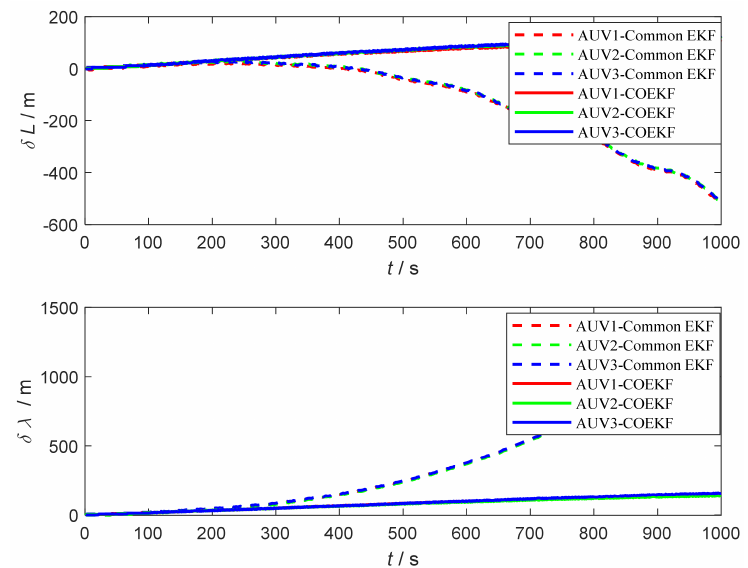
Figure 4. Velocity error comparison curve.